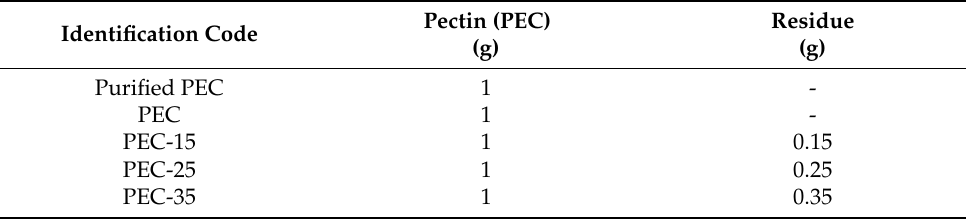
Table 1. Pectin-based film and biocomposite compositions and their identification